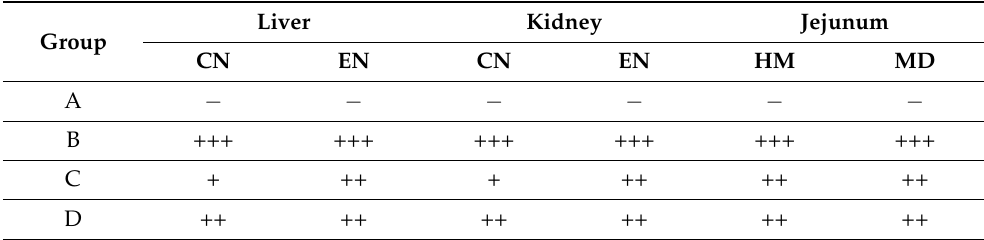
Table 6. Lesion scoring for the gross examination of various organs in birds.